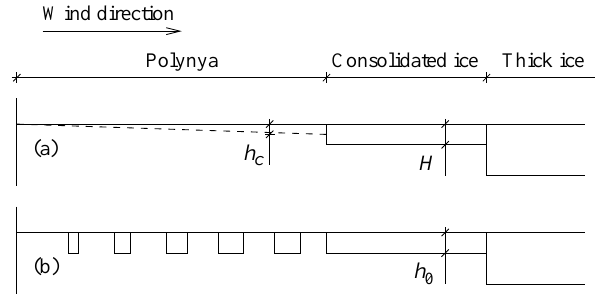
Fig. 1. Polynya formation in polynya flux models and a dynamic- thermodynamic sea-ice model. (a) In the Pease (1987) model, frazil ice that forms inside the polynya is immediately transported to- wards the thick ice. There it forms consolidated ice of thickness H . In the Ou (1988) model, the frazil ice has constant (and fi- nite) drift speed inside the polynya and therefore non-zero thick- ness h c (dashed line). (b) In a dynamic-thermodynamic sea-ice model newly formed ice is immediately transformed into solid ice of thickness h 0